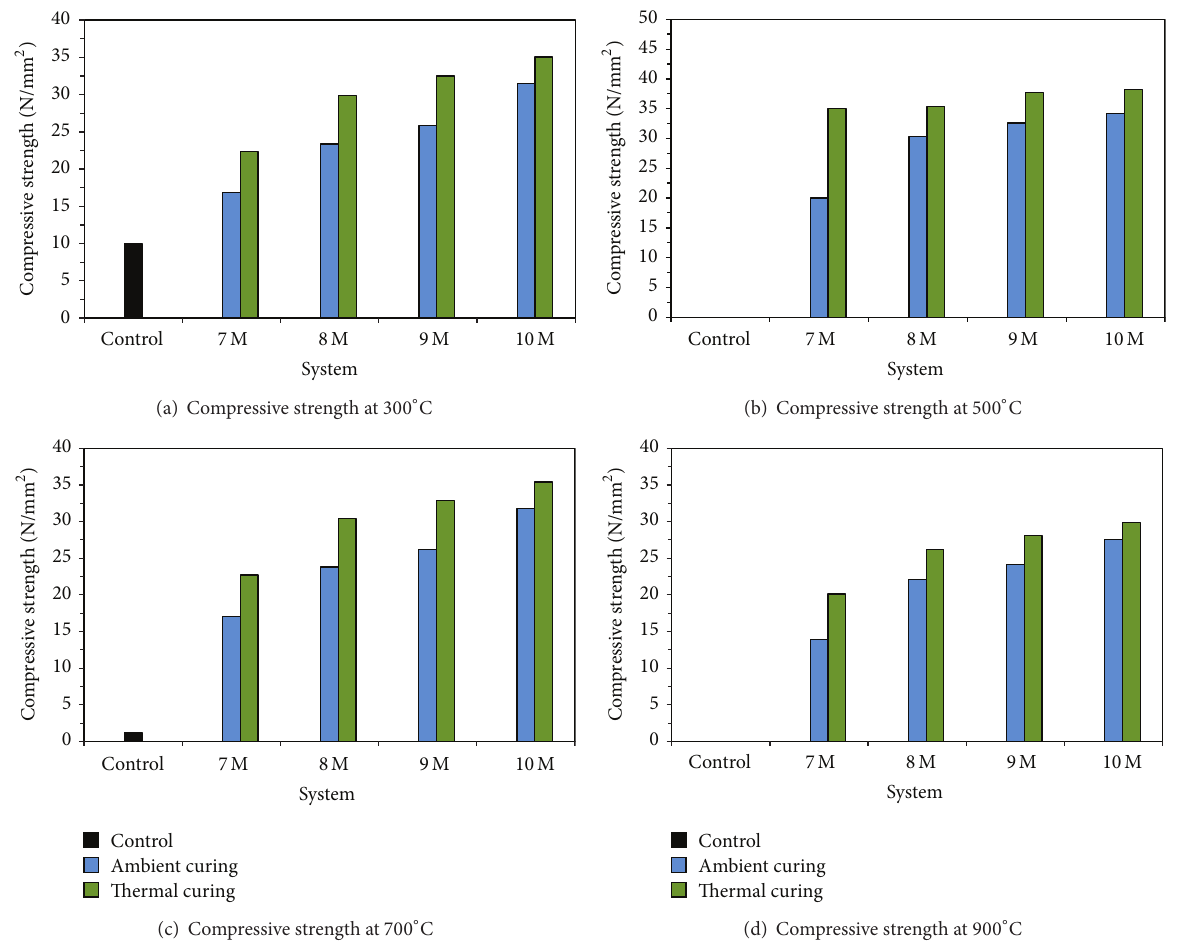
Figure 6: Compressive strength of various systems at elevated temperature.